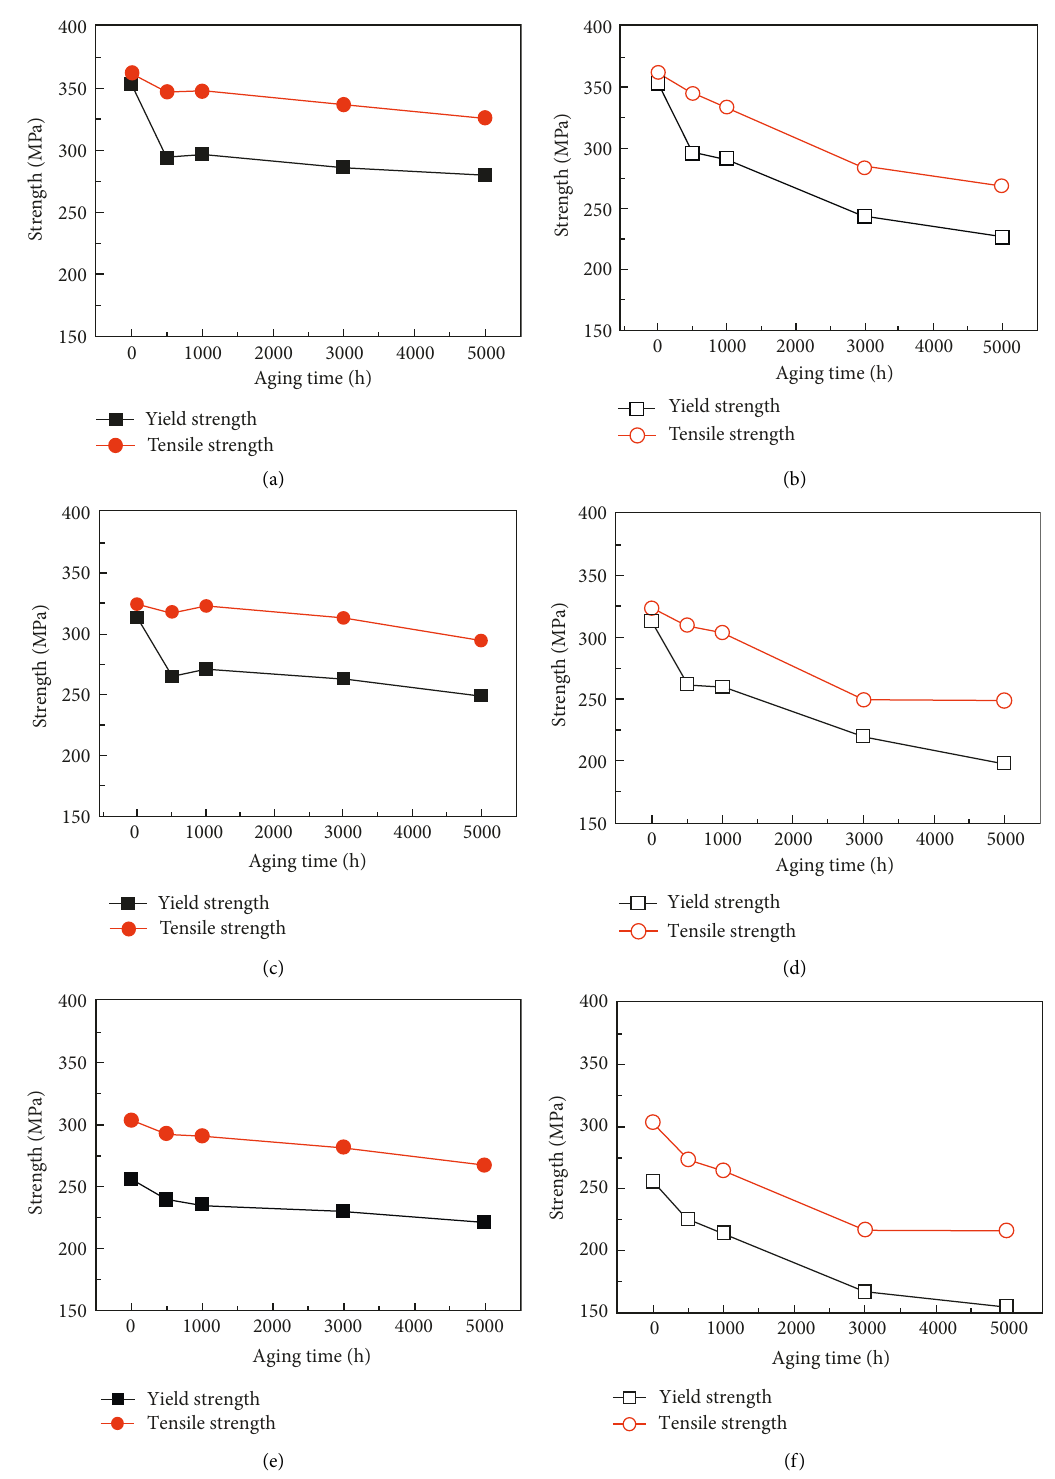
Figure 10: High-temperature mechanical properties of G115 steel as a function of aging time at (a, c, e) 650 ° C and (b, d, f) 700 ° C for testing at (a, b) 630 ° C, (c, d) 650 ° C, and (e, f) 675 °